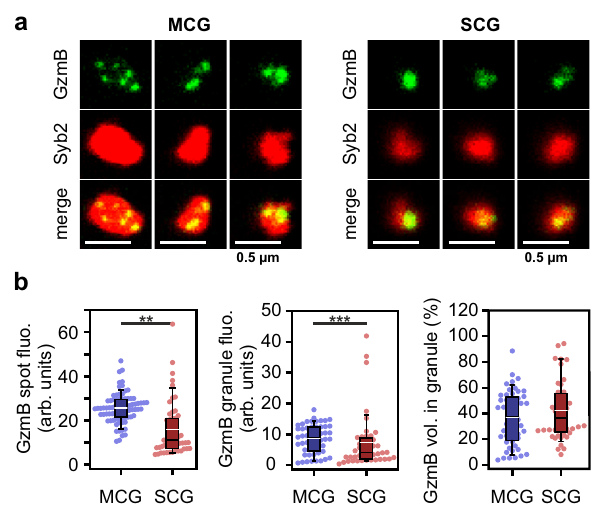
Fig. 6 MCG contain more GzmB than SCG. a 2DSTED single plane images of individual granules from fraction 6 (left) and 8 (right), that were isolated from Syb2 KI mice, and were gently seeded on glass coverslips to ensure their integrity. Granules were stained with anti-GzmB (top, green) and anti-RFP with STED compatible secondary antibody to visualize Syb2 (middle, red). The bottom images show the merged channels. No deconvolution was applied on the images in order to preserve the diffuse GzmB staining visible especially in SCGs. b Analysis of GzmB content of the granules depicted in ( a ) shown as scatter dot plots superimposed with a box plot, in which the center black line is the median and the white line the average. The boundaries of the box represent the 25th to 75th percentiles, while the whiskers are 10th/90th percentiles. Left, mean fl uorescence intensity of the GzmB particles. Center, mean fl uorescence of GzmB spots related to the entire volume of the granule measured on the Syb2 channel. Right, fractional GzmB volume over the entire volume the granule given in percent. N gradiant = 1; n granules = 52 and 44 from fraction 6 (MCGs) and 8 (SCGs) respectively. ** p = 0.006, *** p < 0.001 computed with the Mann – Whitney U test. Source data are provided as a Source data fi